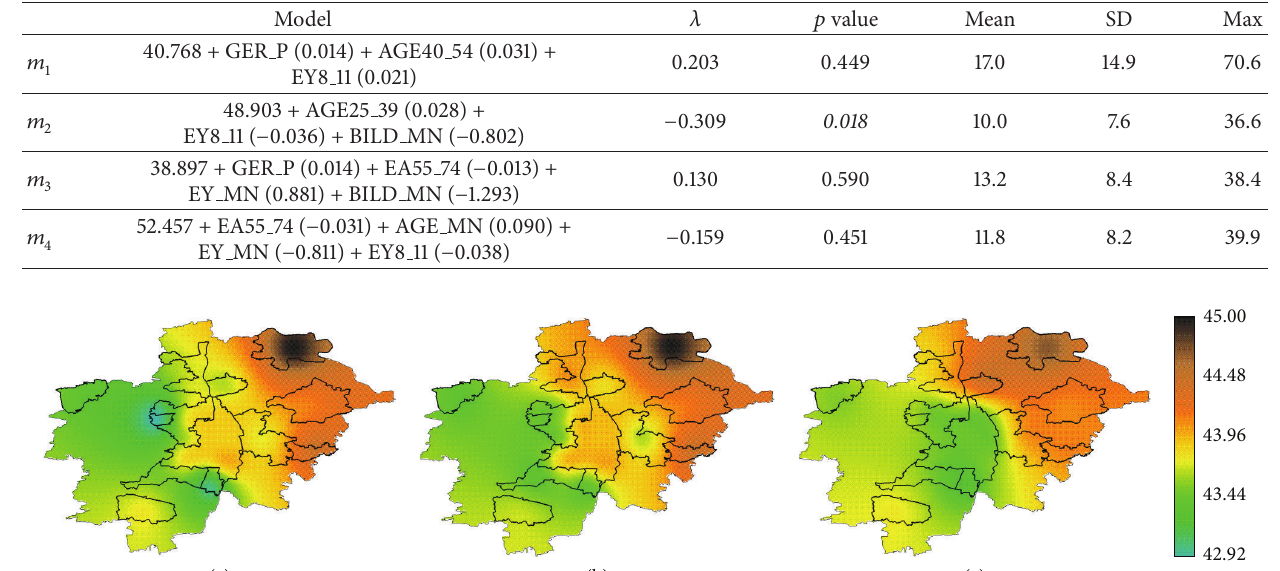
Table 4: Best spatial autoregressive models fitting the data. The spatial autocorrelation left in the residuals ( 𝜆 ) and the p value of the likelihood ratio test, comparing the residuals of the fitted model with the one with no spatial autocorrelation (i.e., 𝜆 = 0 ), are indicated for each model. In order to compare these four models, landscapes were created as the pixelwise difference between the observed and the predicted genetic landscape for each 𝑛 model ( 𝐻 𝑂 (GER) −𝐻 ( 𝑚 𝑛 )). Differences were computed in percentage to the maximal range of values of the 𝐻 𝑂 (GER) landscape. Mean, standard deviation (SD), and maximal values (Max) of the differences are indicated.